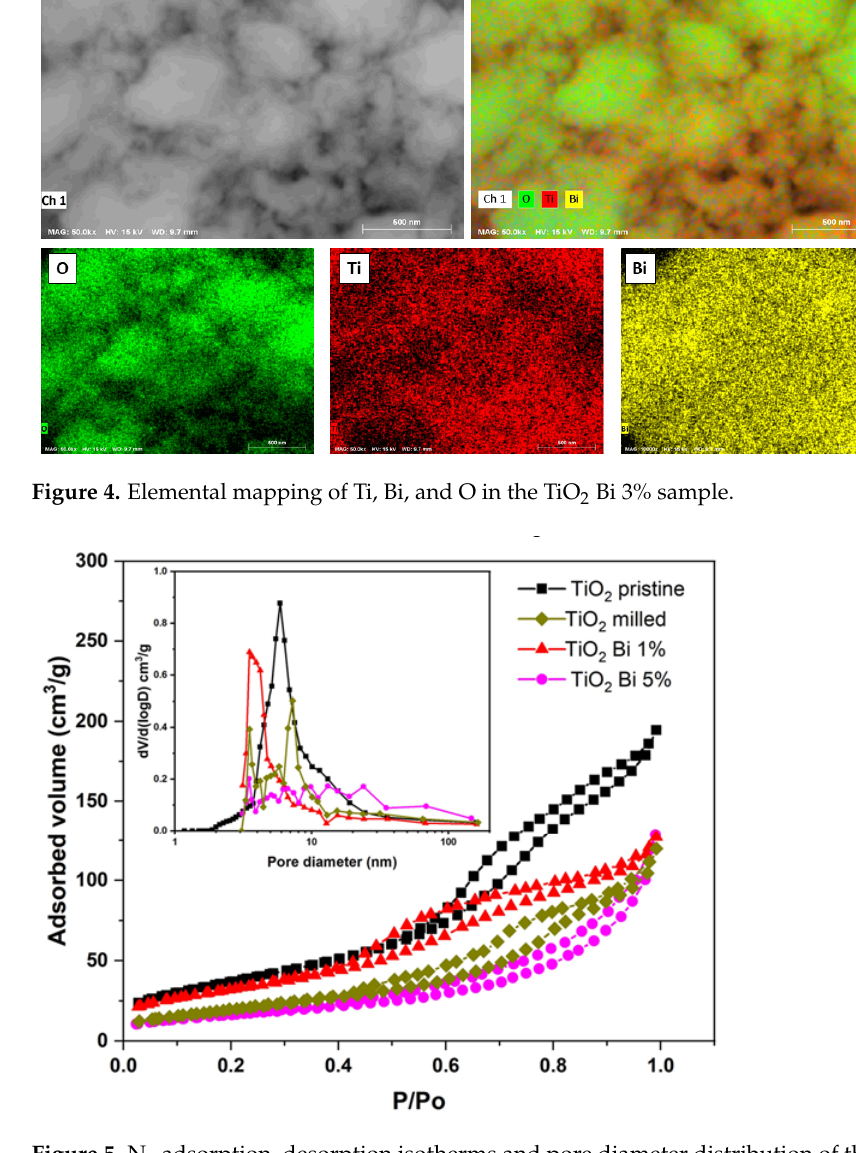
Figure 4. Elemental mapping of Ti, Bi, and O in the TiO 2 Bi 3% sample.